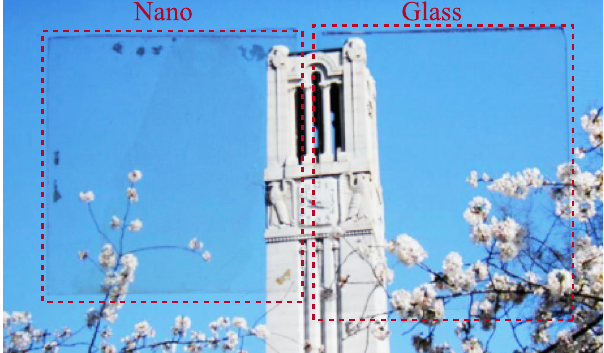
Figure 5. Picture of 10 nm Al 2 O 3 nanolattice sample and bare glass. “Nano” is the Al 2 O 3 nanolattice film with 10 nm shell thickness. A display screen was used as backlit background. Scale bar is 1